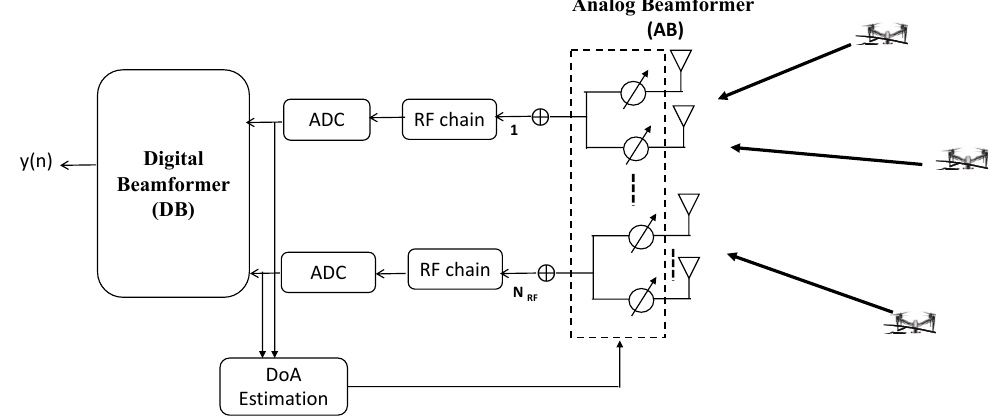
Figure 2. Hybrid mmWave beamformer with DoAs